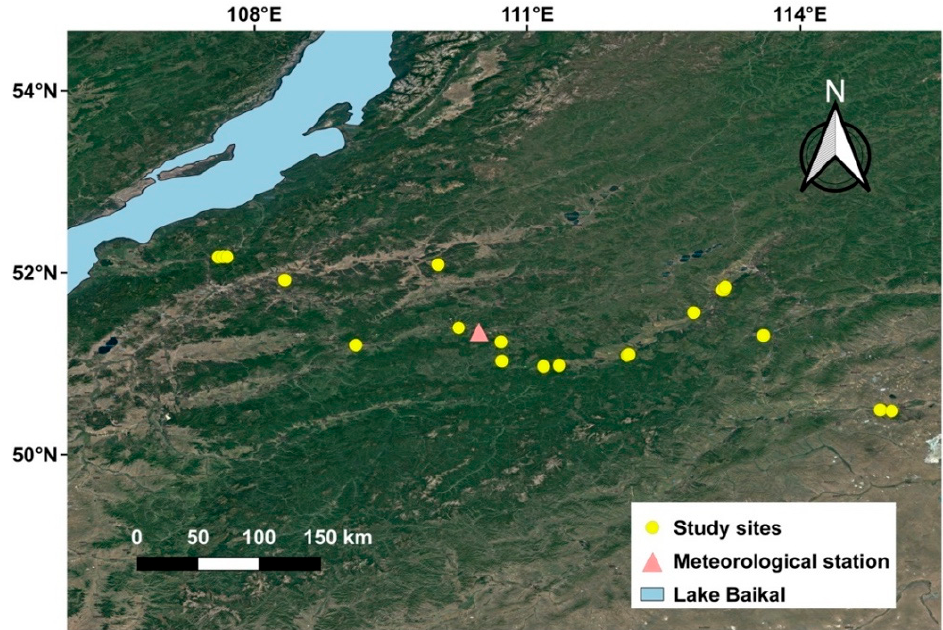
Figure 1. Study region and locations of field sites and the meteorological station to the east of Lake Baikal, Southern Siberia, Russia. Additionally, see Supplementary Figure S1 for locations of local major population centers (omitted here for clarity).